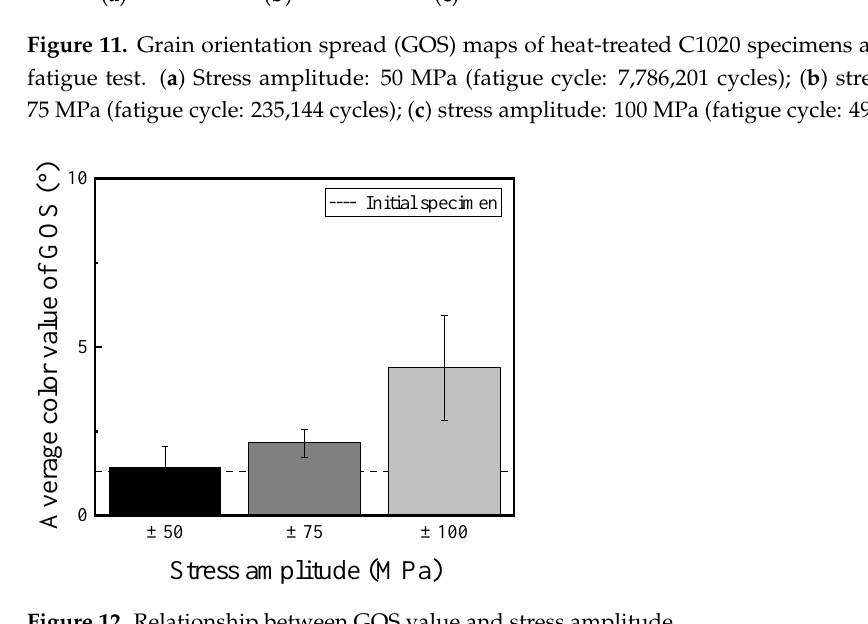
Figure 12. Relationship between GOS value and stress amplitude.